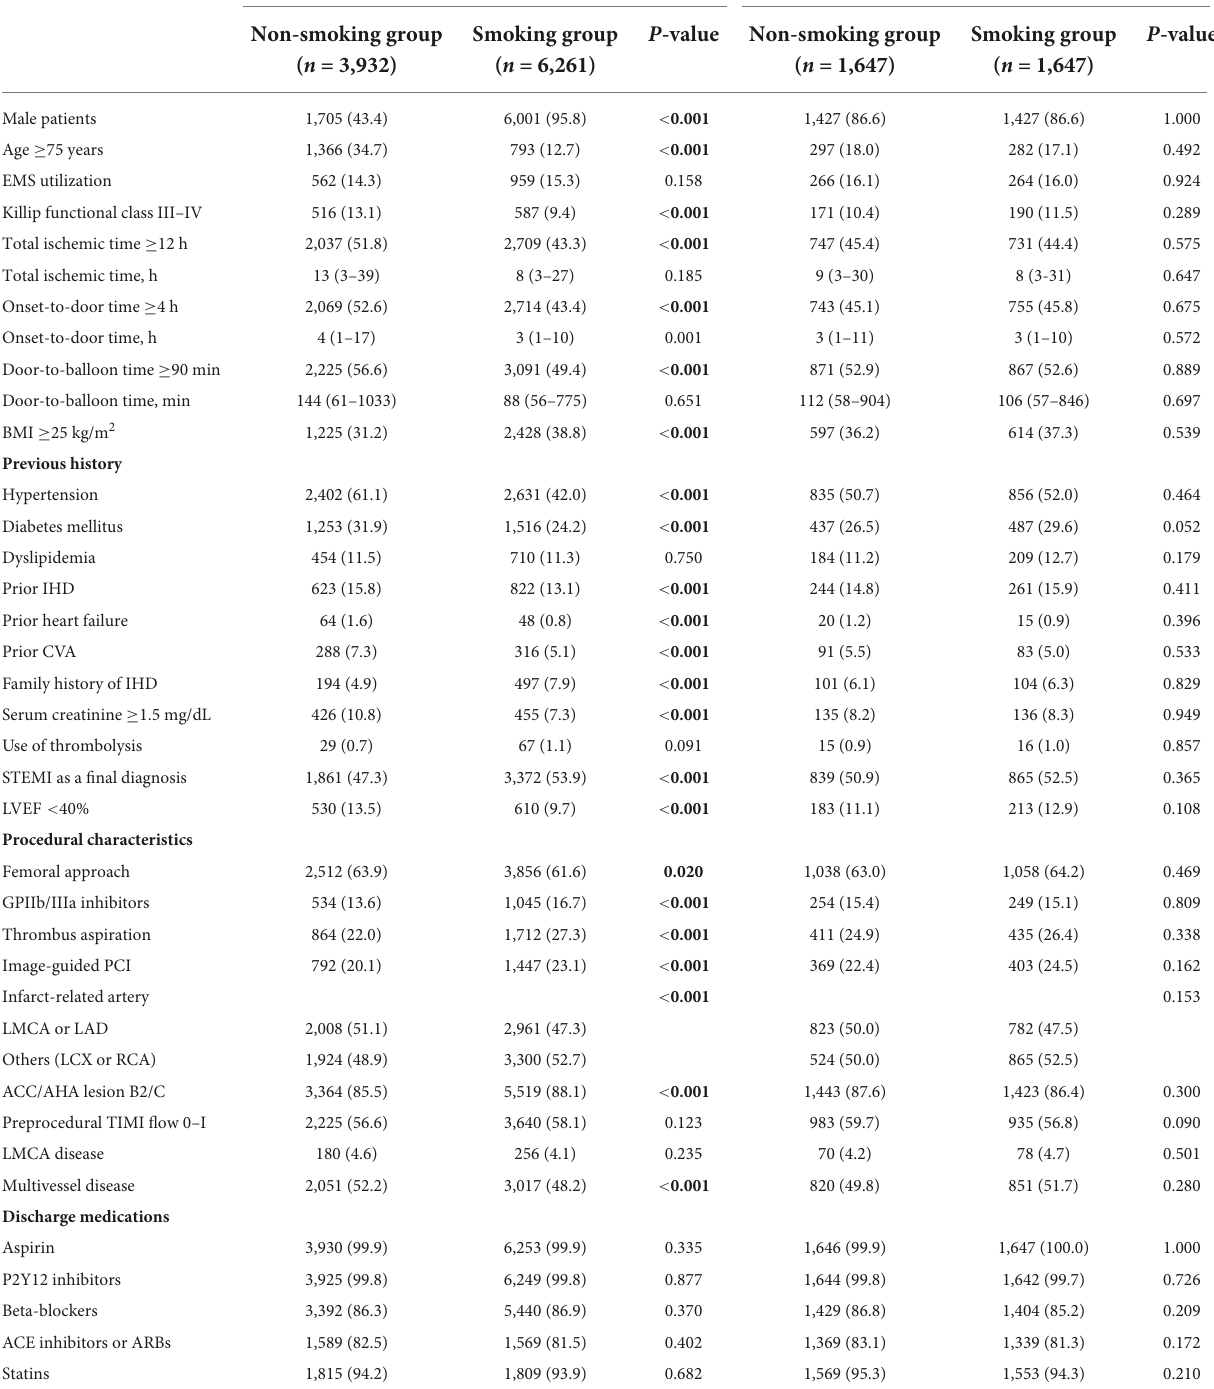
TABLE 1 Baseline characteristics of the